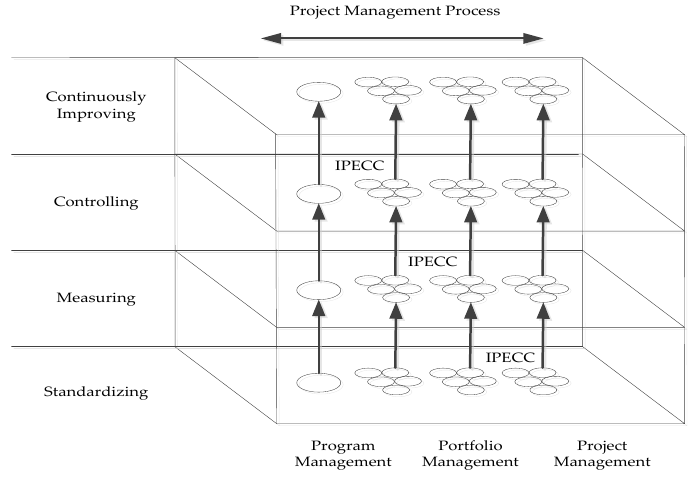
Figure 1. Framework of the OPM3. Table 4. Environmental management index system of CPs.